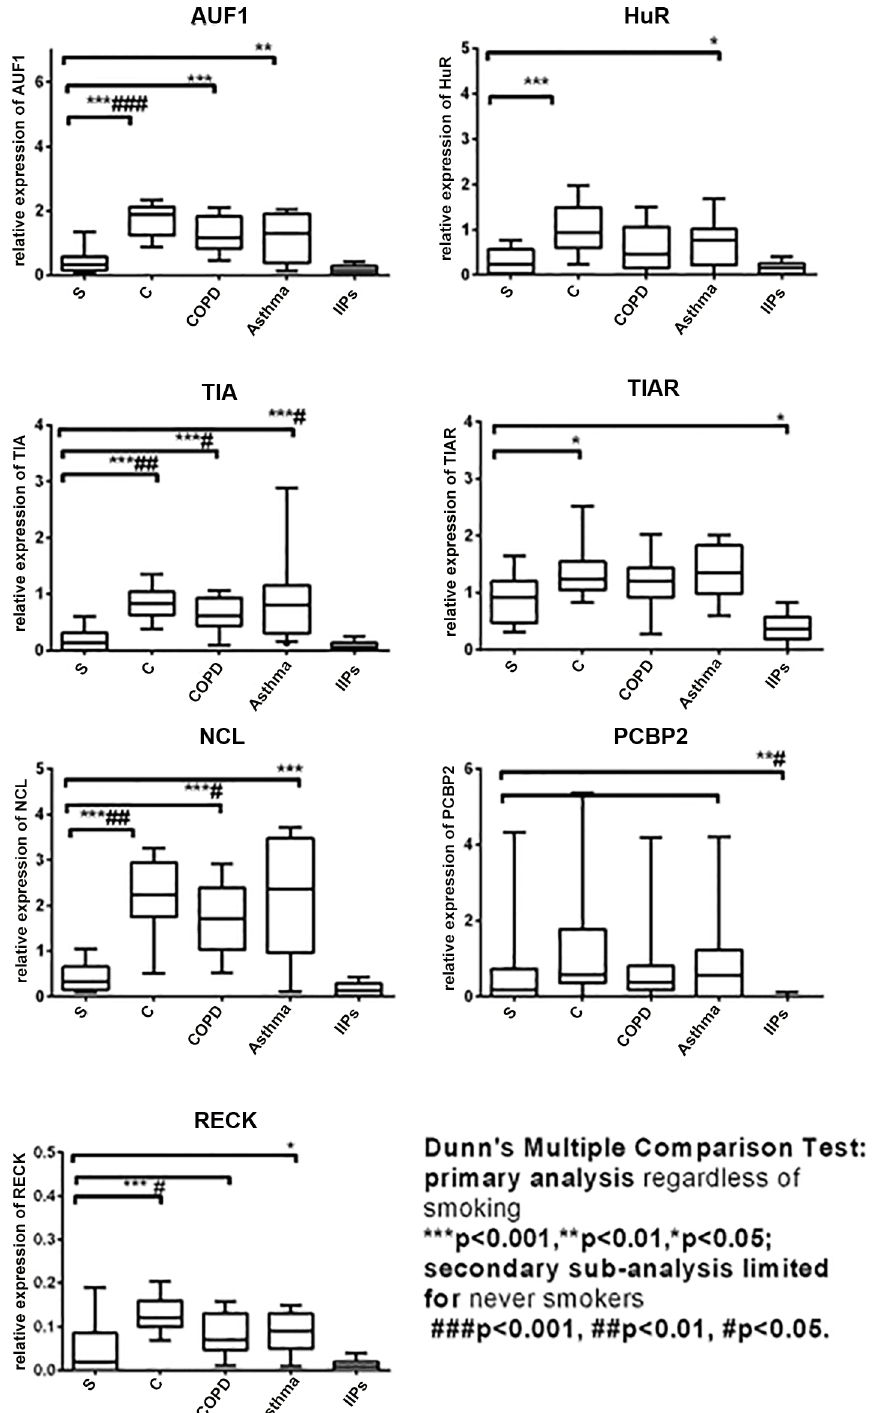
Fig 1. The relative mRNA expression of RNA-binding proteins (RBPs) and an inhibitor of proteolytic activity RECK in pulmonary sarcoidosis (S) in comparison with healthy controls (C) and patients with chronic obstructive pulmonary disease (COPD), asthma and idiopathic interstitial pneumonia (IIPs).